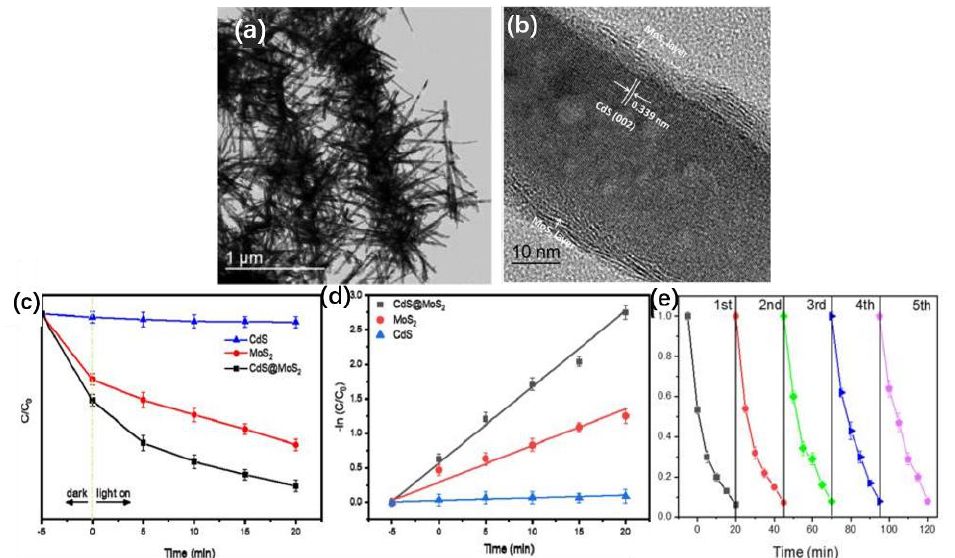
Figure 1. ( a ) Transmission electron microscopy (TEM) image of CdS@MoS 2 (5%). ( b ) High-resolution TEM (HRTEM) image of the obtained CdS@MoS 2 (5%) heterostructured nanocomposites (HSNPs). ( c ) Photocatalytic activities of pure CdS, pure MoS 2 , and CdS@5%MoS 2 HSNP in the degradation of methyl blue (MB) by visible light irradiation and ( d ) corresponding linearized kinetics. ( e ) Different cycles of photocatalytic degradation of methyl bromide by CdS@5%MoS 2 HSNPs under visible light irradiation. Copyright © 2020 American Chemical Society.